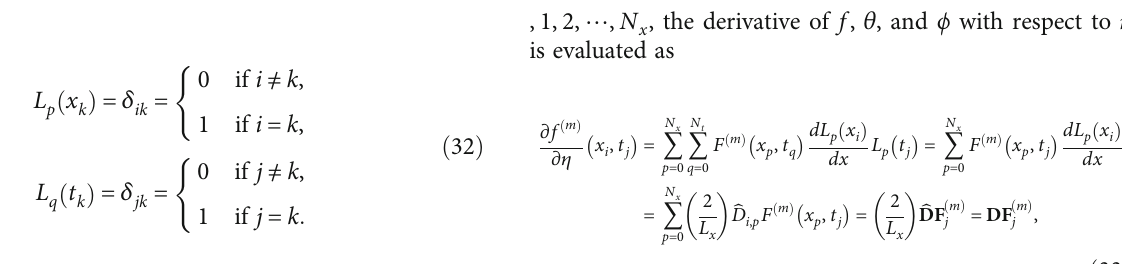
Figure 7: Temperature pro fi le for di ff erent values of Ec when λ = 0 : 1, N = 0 : 5, n = 0 : 5, f = NR = 0 : 2, Sc = 0 : 6 , and Pr = 1